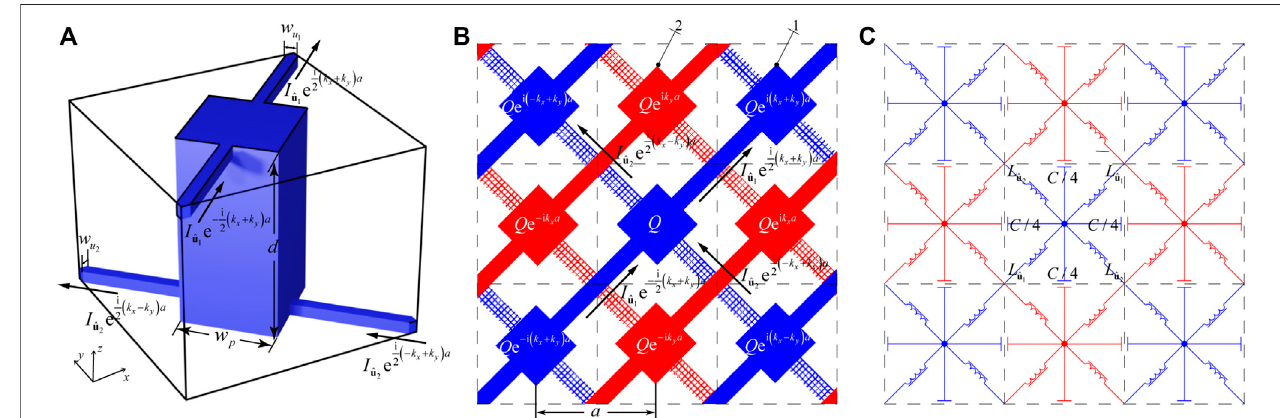
FIGURE 2 | 2D double-mesh MM. (A) Unit cell (lattice constant a = 1 cm ). The metallic block (width w and height d ) centered at the unit cell is connected to the adjacent blocks by two metallic wires (width w ^ u and n = 1, 2) in ^ u 1 and ^ u 2 directions. The alternating currents on the wires crossing through the cell boundaries would n lead to a time-varying charge Q accumulated on the block. (B) 3 × 3 supercell of the 2D double-mesh MM. It shows that the MM is composed of two disconnected metallicmeshes(blue and red) with independentpotentials. The potential difference for the central unit cellis assumed to be Δ φ , and then, the potential differences elsewhere can be obtained using Bloch theorem. (C) Equivalent circuit model of the 2D double